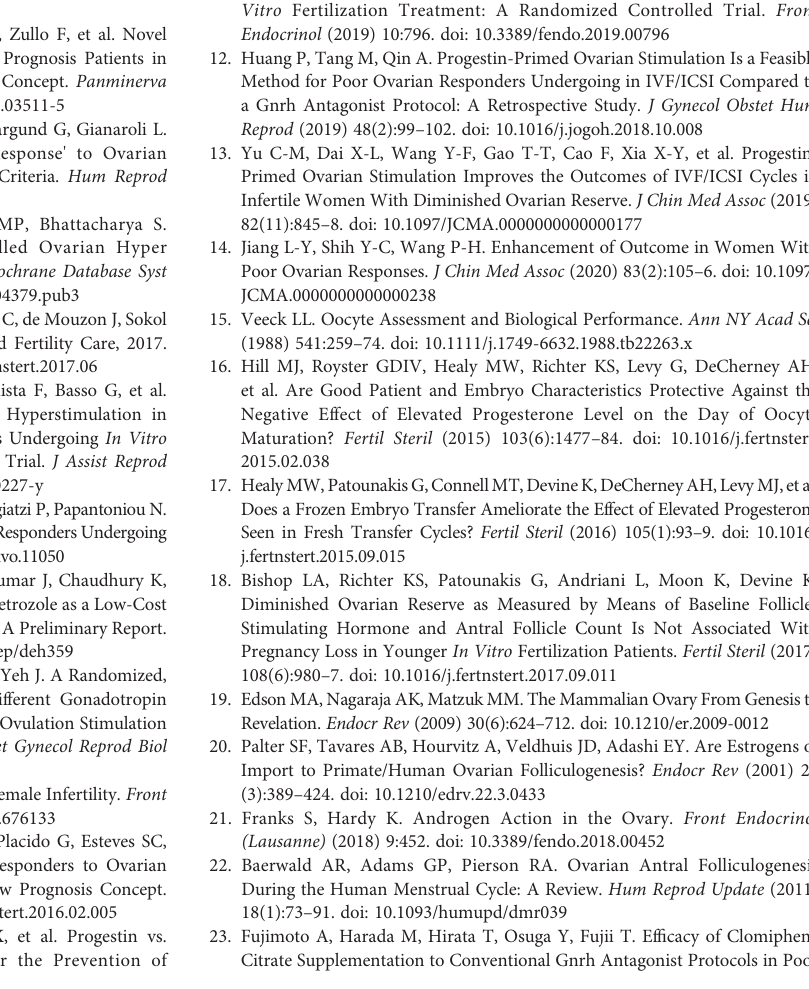
Figshare. Supplementary Figure 1 (doi: 10.6084/m9. fi